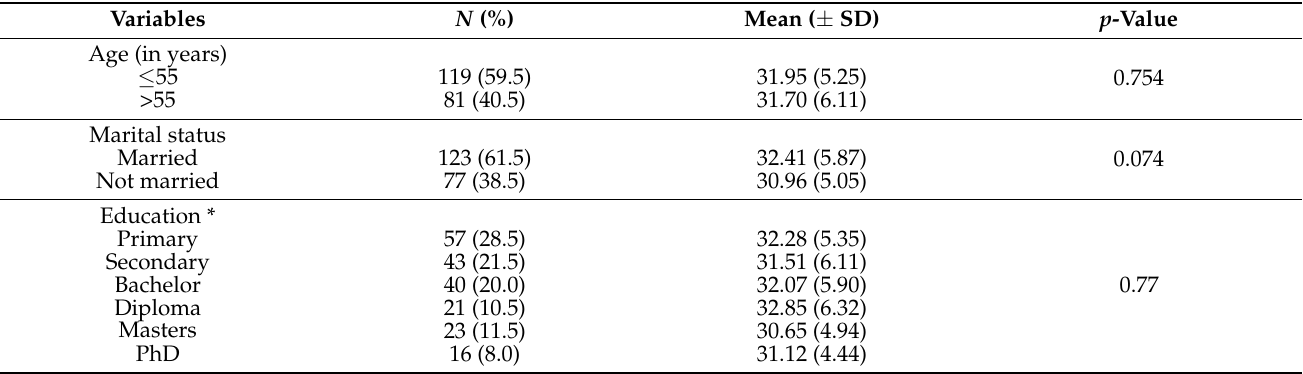
Table 1. Associations between characteristics of women with breast cancer and OHIP-14